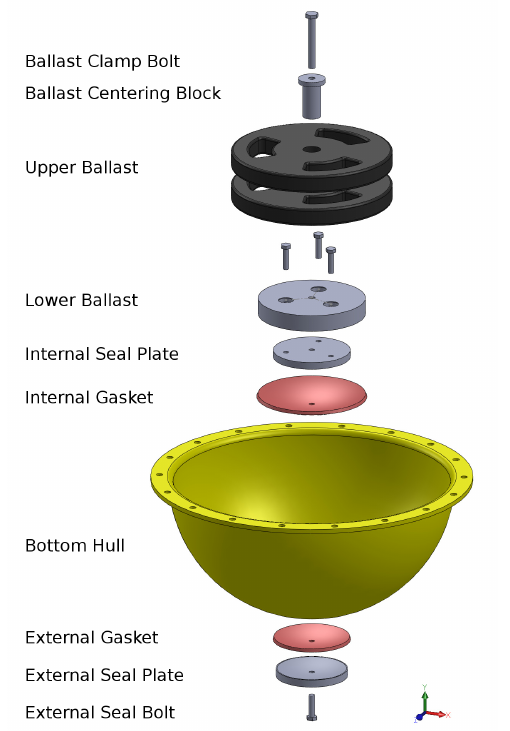
Figure 2. Exploded view of the ballast assembly for the wave measurement buoy.